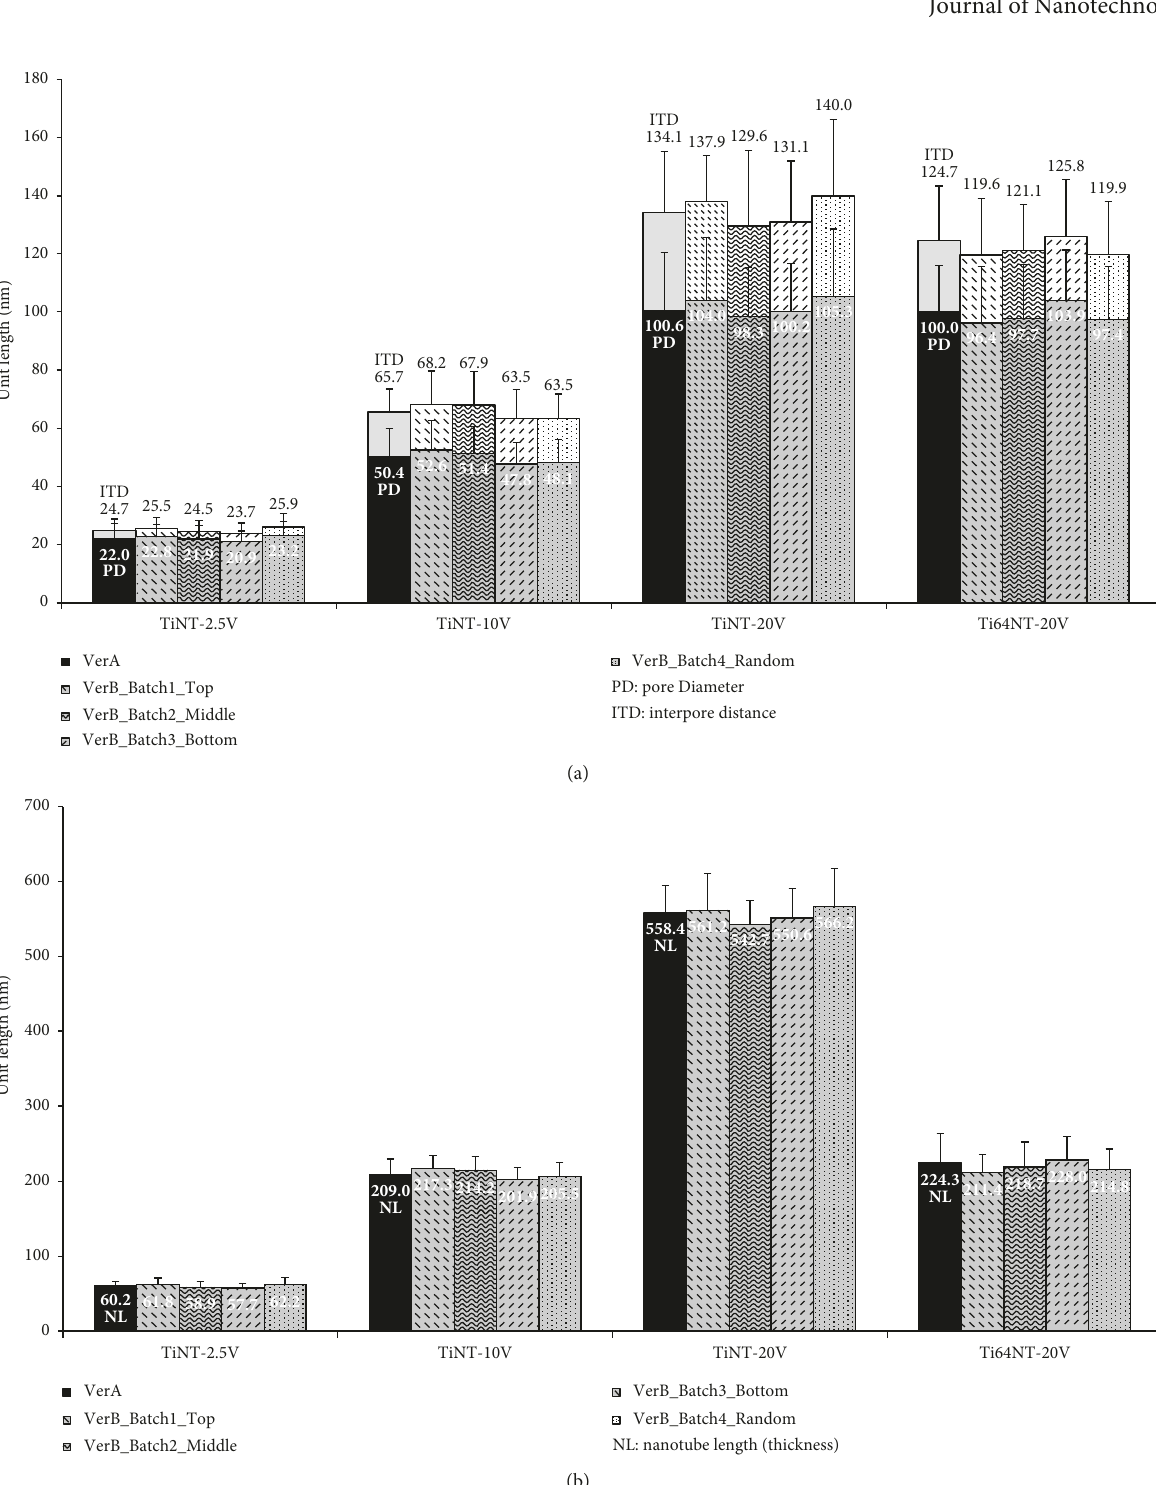
100, error bars represent (cid:30) 15, error bars (cid:30)